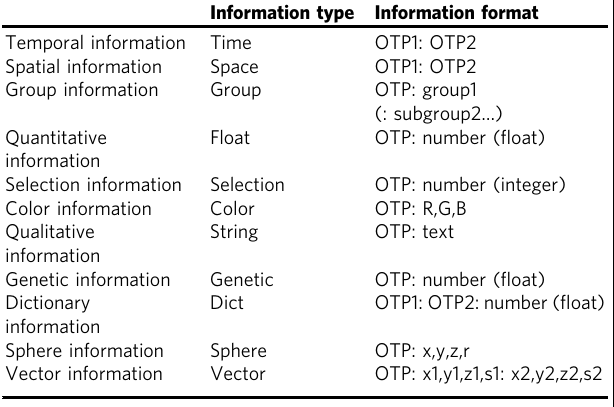
Table 2 Overview of morphological information